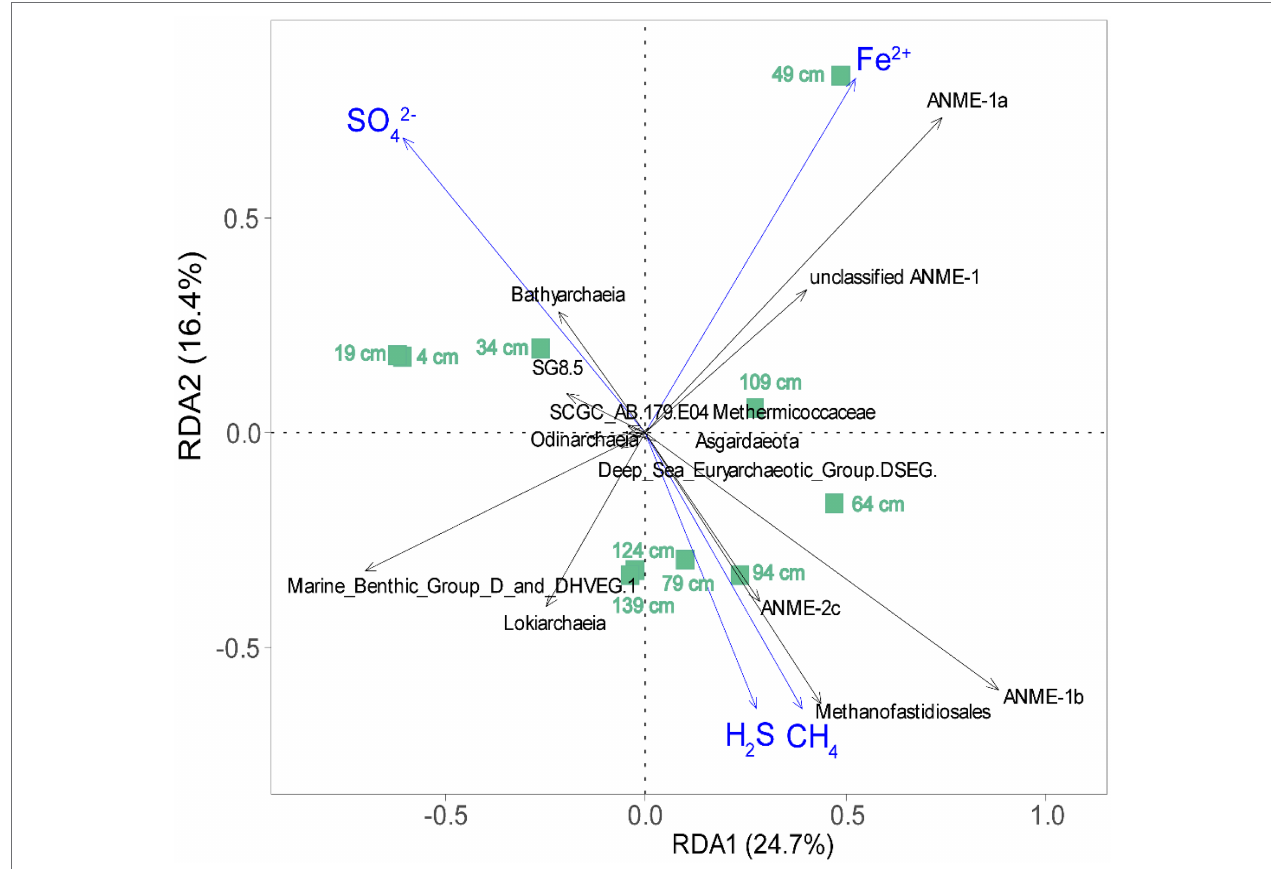
FIGURE 7 | Redundancy analysis (RDA) ordination plot for the first two principal dimensions of the relationships between archaeal community structure and environmental variables (sulfate, CH 4 , H 2 S, and Fe 2+ ) in this study. The green square represents 10 detected sediment samples in the OT cold seep sediments; environmental parameters and microbial taxa with a goodness of fit of at least 0.45 are represented as blue arrows and black arrows,